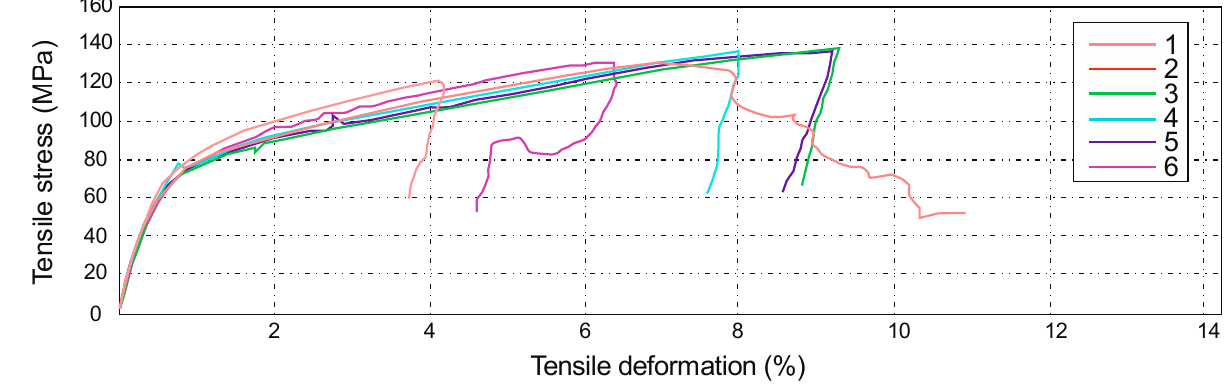
Figure 16. Diagram showing the tensile stress and absolute deformation of Roving IMS65 reinforced laminate, 0/90 ◦ configuration [31].